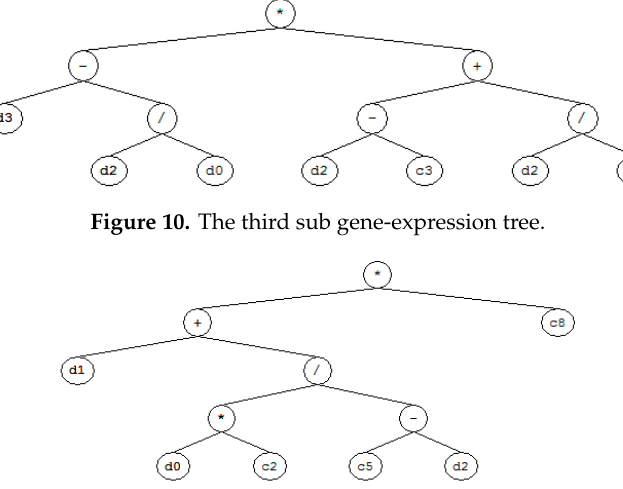
Figure 9. The second sub gene-expression tree.